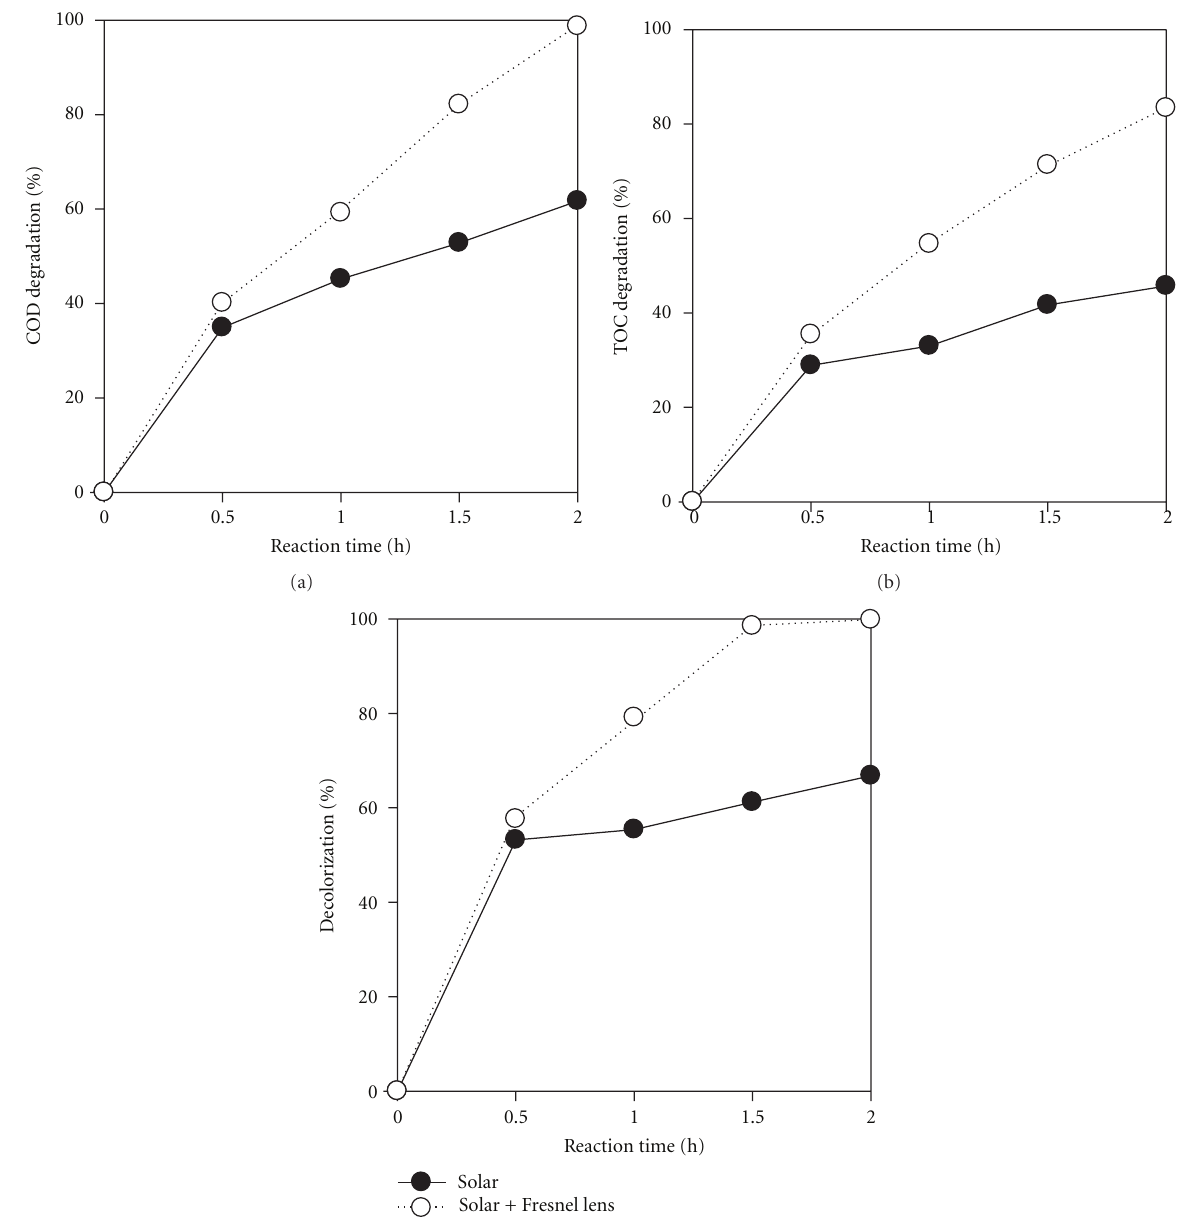
Figure 4: E ff ect of Fresnel lens on the degradation e ffi ciency of AO10 dye wastewater in winter season